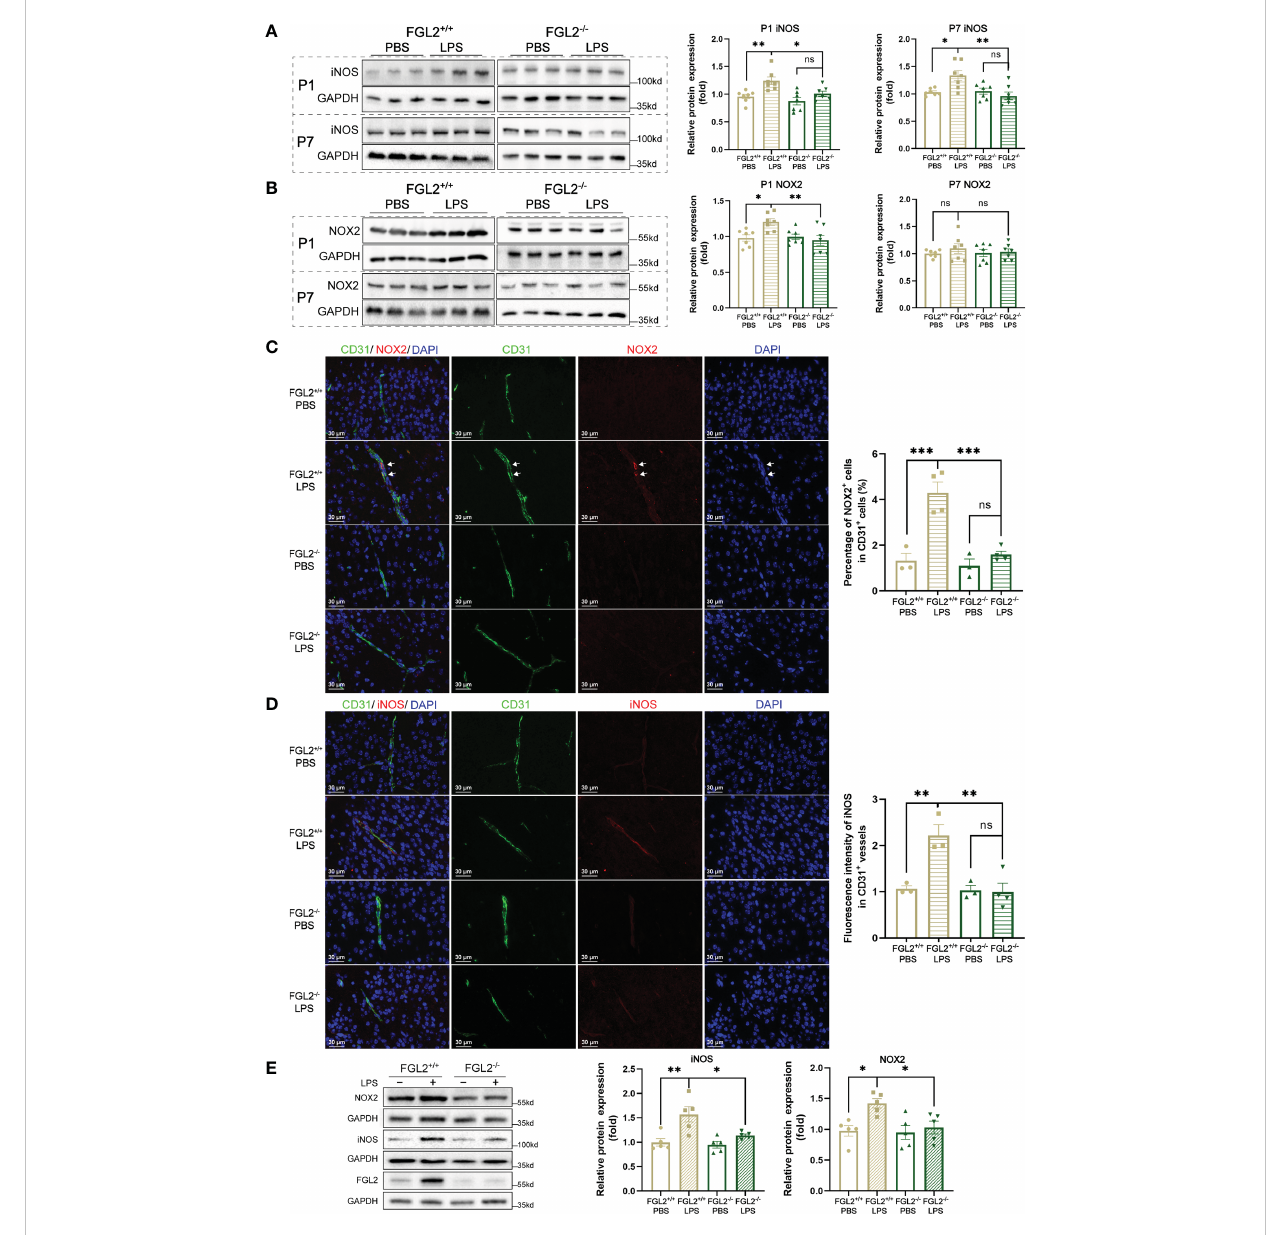
FIGURE 4 FGL2 de fi ciency decreased the maternal in fl ammation-induced endothelial expressions of NOX2 and iNOS. (A) The protein expressions of iNOS in brain at P1 and in cortex at P7 ( n = 7). (B) The protein expressions of NOX2 in brain at P1 and in cortex at P7 ( n = 7). (C) NOX2 expressions in CD31+ vessels by immuno fl uorescence staining in cortex at P7 ( n = 3:4:3:4). The number of NOX2+ and CD31+ cells were counted manually by the ImageJ software, and the percentage was calculated. Representative images and quantitative results were shown. White arrows points to the representative cells. Scale bar= 30 m m. (D) iNOS expressions in CD31+ vessels by immuno fl uorescence staining in cortex at P7 ( n = 3:3:3:4). The fl uorescence intensity of iNOS in CD31+ vessels was analyzed by the ImageJ software and normalized to controls. Representative images and quantitative results were shown. Scale bar= 30 m m. (E) The protein expressions of iNOS and NOX2 in BMECs ( n = 5). FGL2 +/+ and FGL2 -/- BMECs were treated with LPS (5 m g/ml) or PBS for 24h. The data was expressed as mean ± SEM and was the representative of at least three independent experiments. Statistical differences were assessed by one-way ANOVA with Tukey ’ s post-hoc test for multiple groups. ns P >0.05, * P <0.05, ** P <0.01, *** P